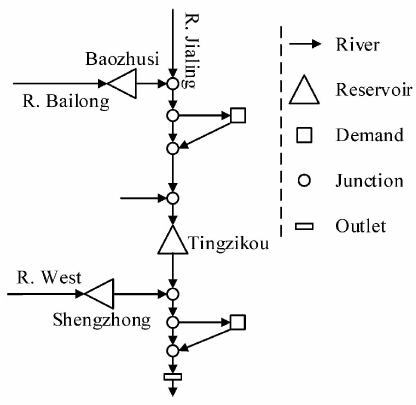
Figure 6. Sketch map of the investigated